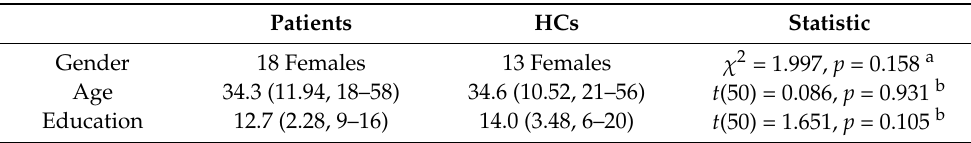
Table 1. Demographic information of participants.